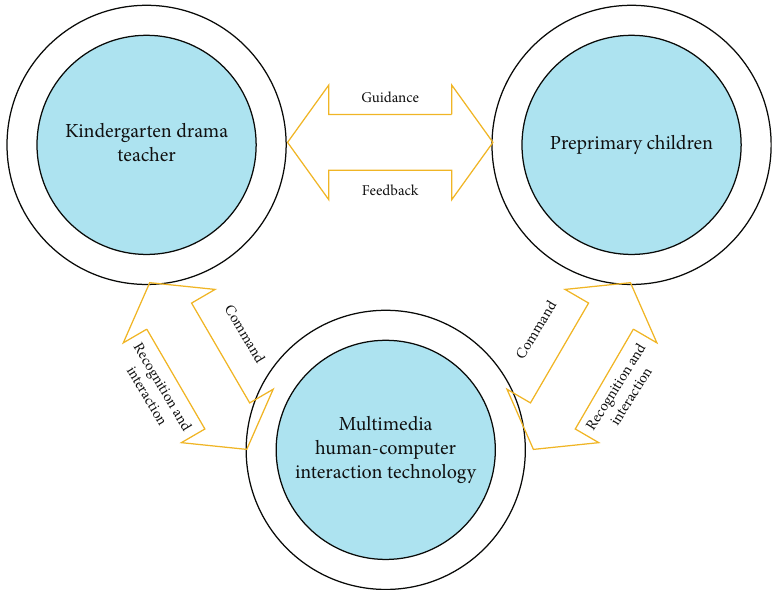
Figure 3: Schematic diagram of